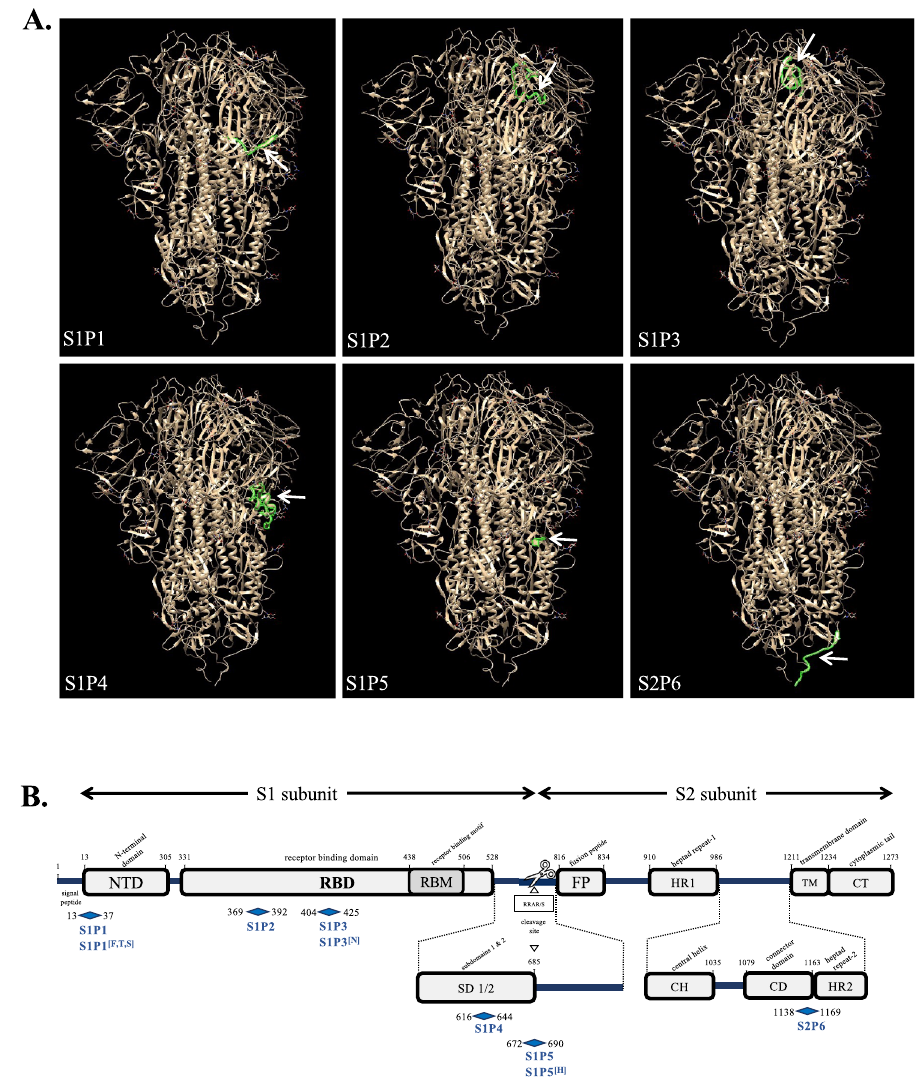
Figure 1. Position of B-cell epitope peptides on SARS-CoV-2 spike protein. In ( A ), positions of the six B-cell epitope peptides colored in green on a single protomer of SARS-CoV-2 spike protein trimer (EMD data resource: EMD-2256). The blank arrow indicates their position on the protomer. In ( B ), schematic organization of SARS-CoV-2 spike protein with the S1 and S2 subunits and their different domains and motifs is shown. The six synthetic peptides S1P1, S1P2, S2P3, S1P4, S1P5, and S2P6 peptides and their variants S1P1 [F,T,S] , S1P3 [N] , and S1P5 [H] are mapped on the SARS-CoV-2 spike